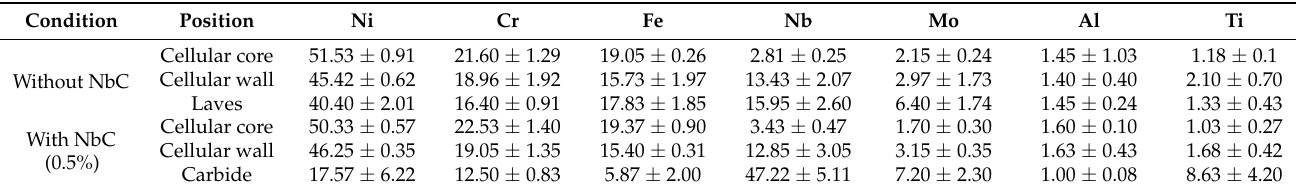
Table 2. TEM-EDS composition analysis of cellular structure and particles of as-built condition (at%). Condition Position Ni Without